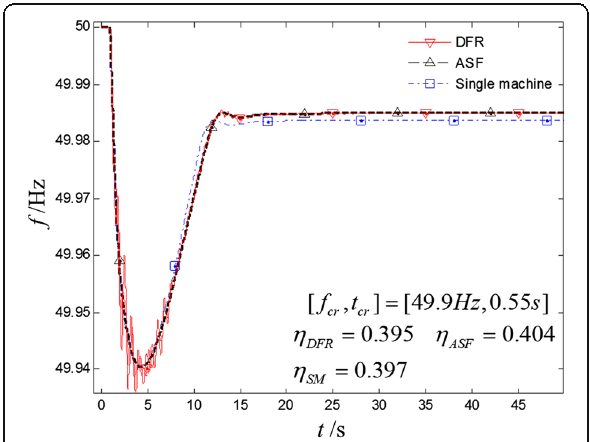
Fig. 6 Frequency response with tripping 300 MW generation in the 1000-bus